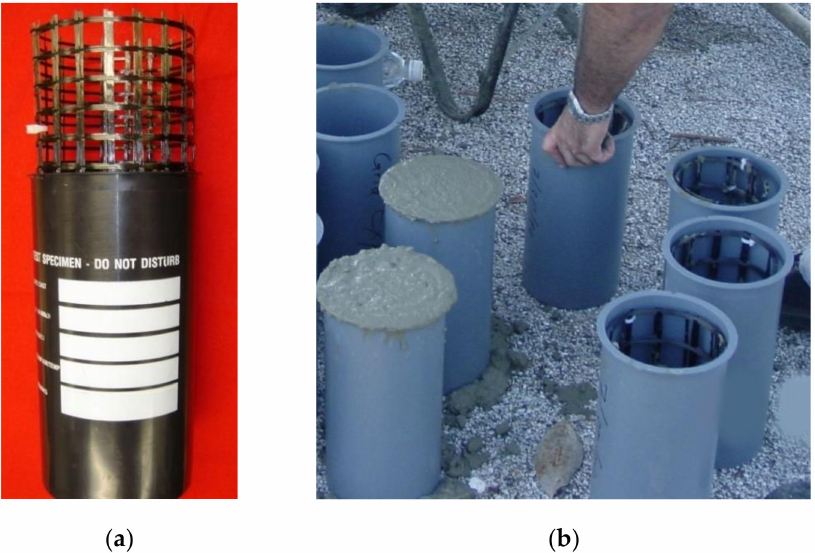
Figure 4. CFRP grid cylinder manufacturing: ( a ) CFRP grid tube (coil) inside a cylindrical mold prior to casting and ( b ) CFRP grid tubes inside the cylindrical molds during concrete casting